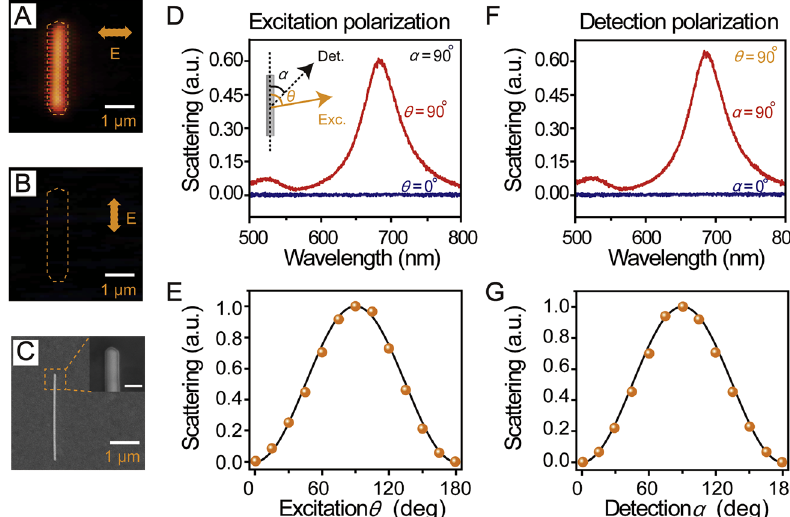
Figure 2: Polarization-dependent DF optical images of the NWOM systems under (A) horizontal excitation (B) perpendicular excitation. (C) SEM image of an NWOM with a detailed SEM image of the end of the Au- NW in the inset. Inset scale bar: 100 nm. (D) and (F) represent the excitation- and detection-polarization dependent scattering, respectively. θ ( α ): the angle between excitation (detection) polarization and the long axis of Au-NW, respectively. excitation and detection polarization are shown in the (E) and (G), respectively, exhibiting a good dipole behavior in light excitation and